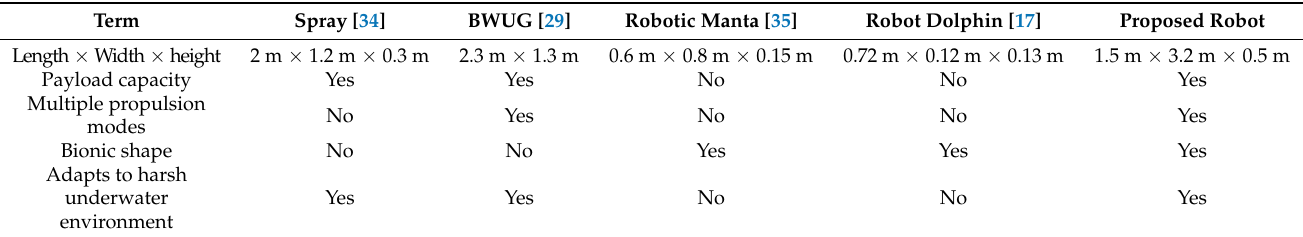
Table 1. Comparison of the underwater